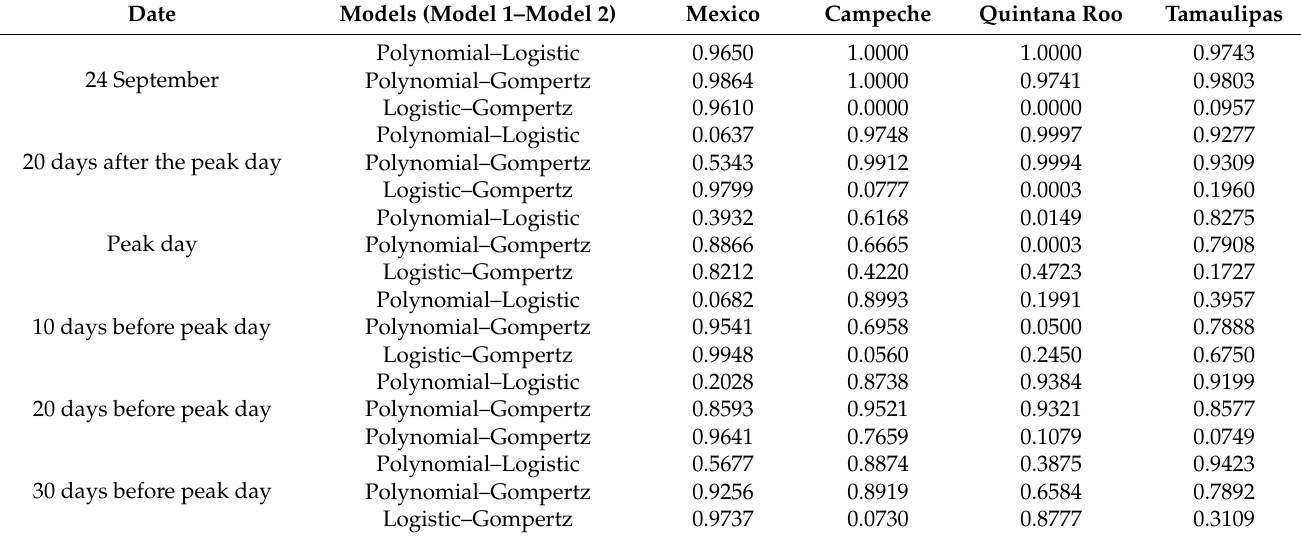
Table 2. Vuong’s model selection test p -values corresponding to the H 2A for the two-step proposed